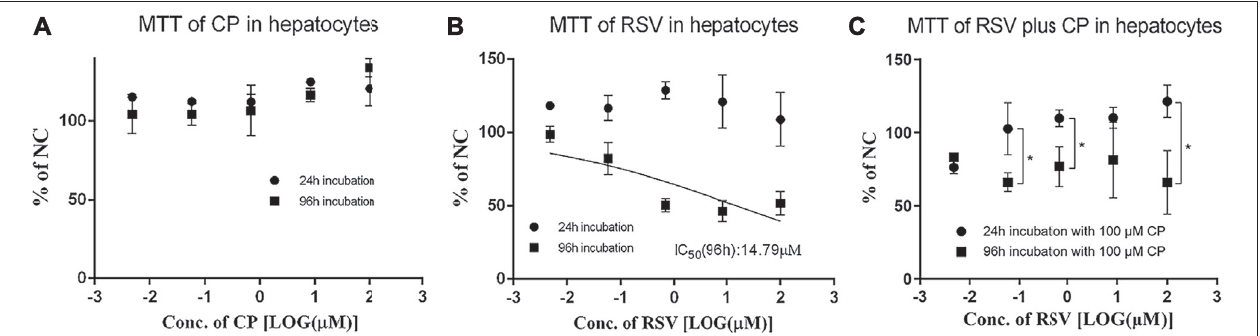
FIGURE3 | Effects of CPand RSV on the viabilityof human primary hepatocytes. The mean relative cell viability (% ofNC) of thehuman primary hepatocytes in the presence of CP (A) , RSV (B), and RSV plus CP (C) . Data are presented as the mean ± S.D. (n (cid:2) 3). * p < 0.05.